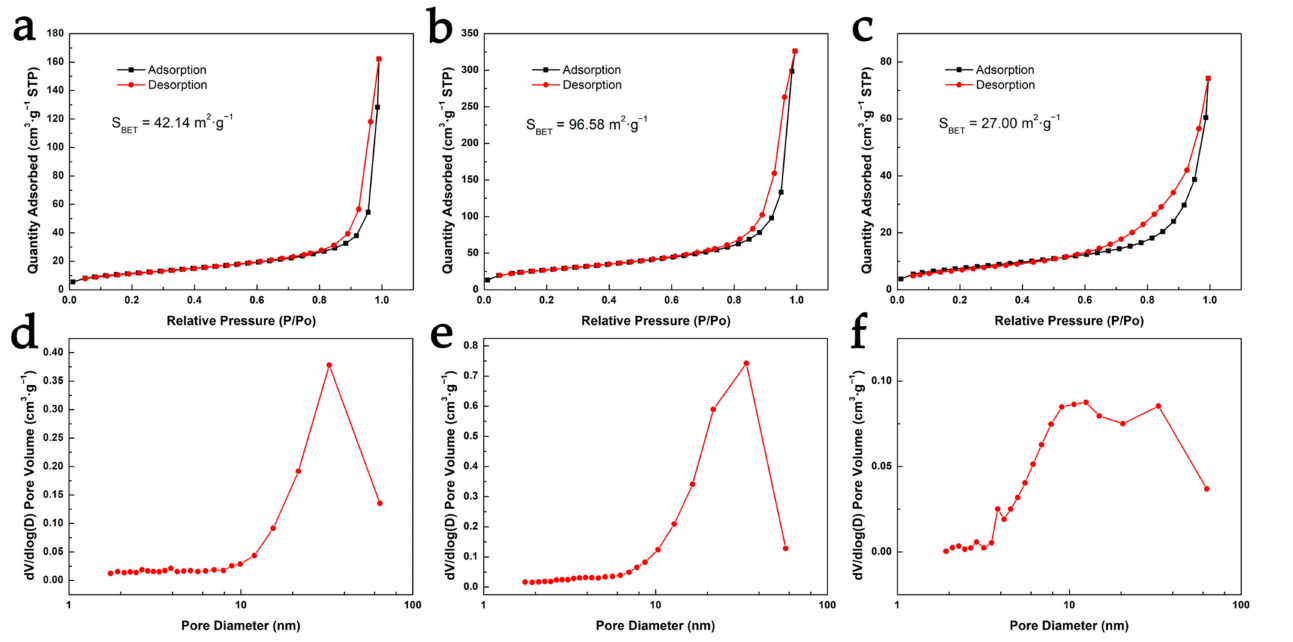
Figure 7. ( a – c ) N 2 adsorption–desorption isotherms and ( d – f ) BJH pore-size distribution of cellulose aerogels prepared under different conditions: ( a , d ) ionic liquid & freeze-drying, ( b , e ) NaOH/urea solution & supercritical drying, and ( c , f ) NaOH/urea solution & freeze-drying. The BET result of cellulose aerogels is respectively inserted in the figures.